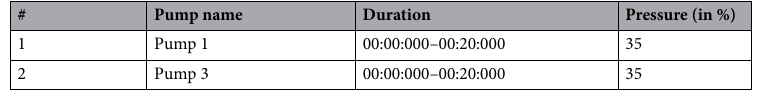
Table 1. Program sequence for demonstrating active control handled by the system (experiment #1).